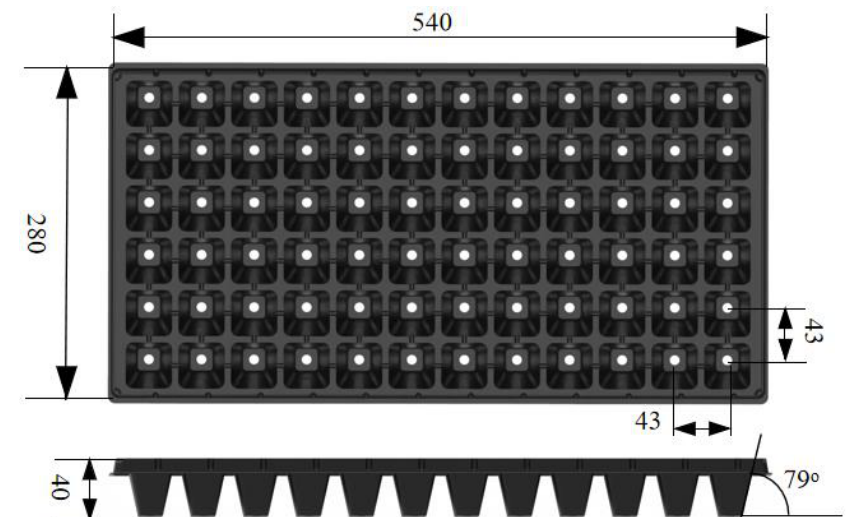
Figure 1. Seedling tray specifications (mm).